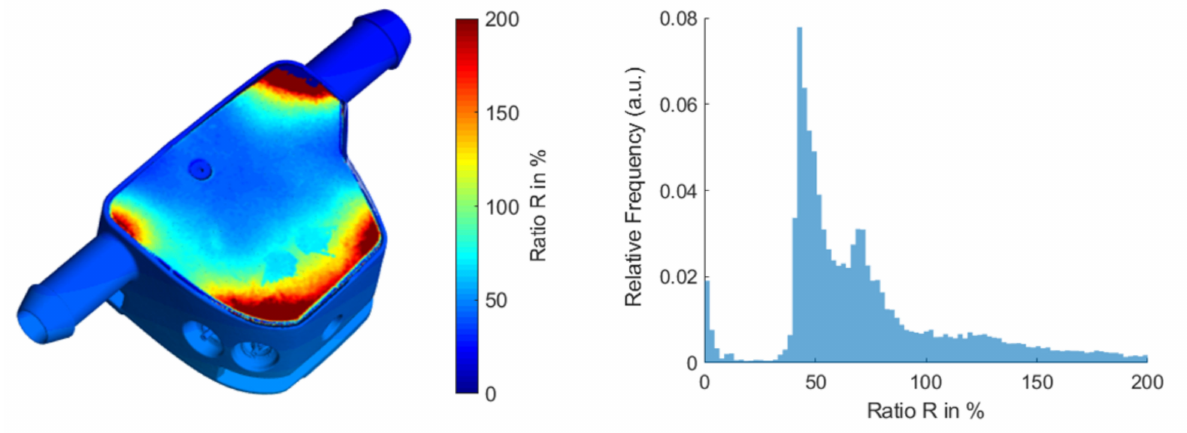
Figure 10. Color-coded 3D representation ( left ) and histogram of the ratio R ( right , bin width of